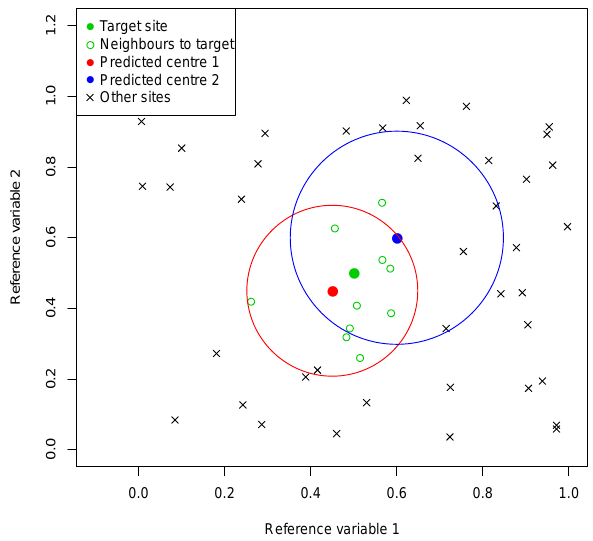
Figure 2. Illustration of the neighbourhoods obtained by the RVN